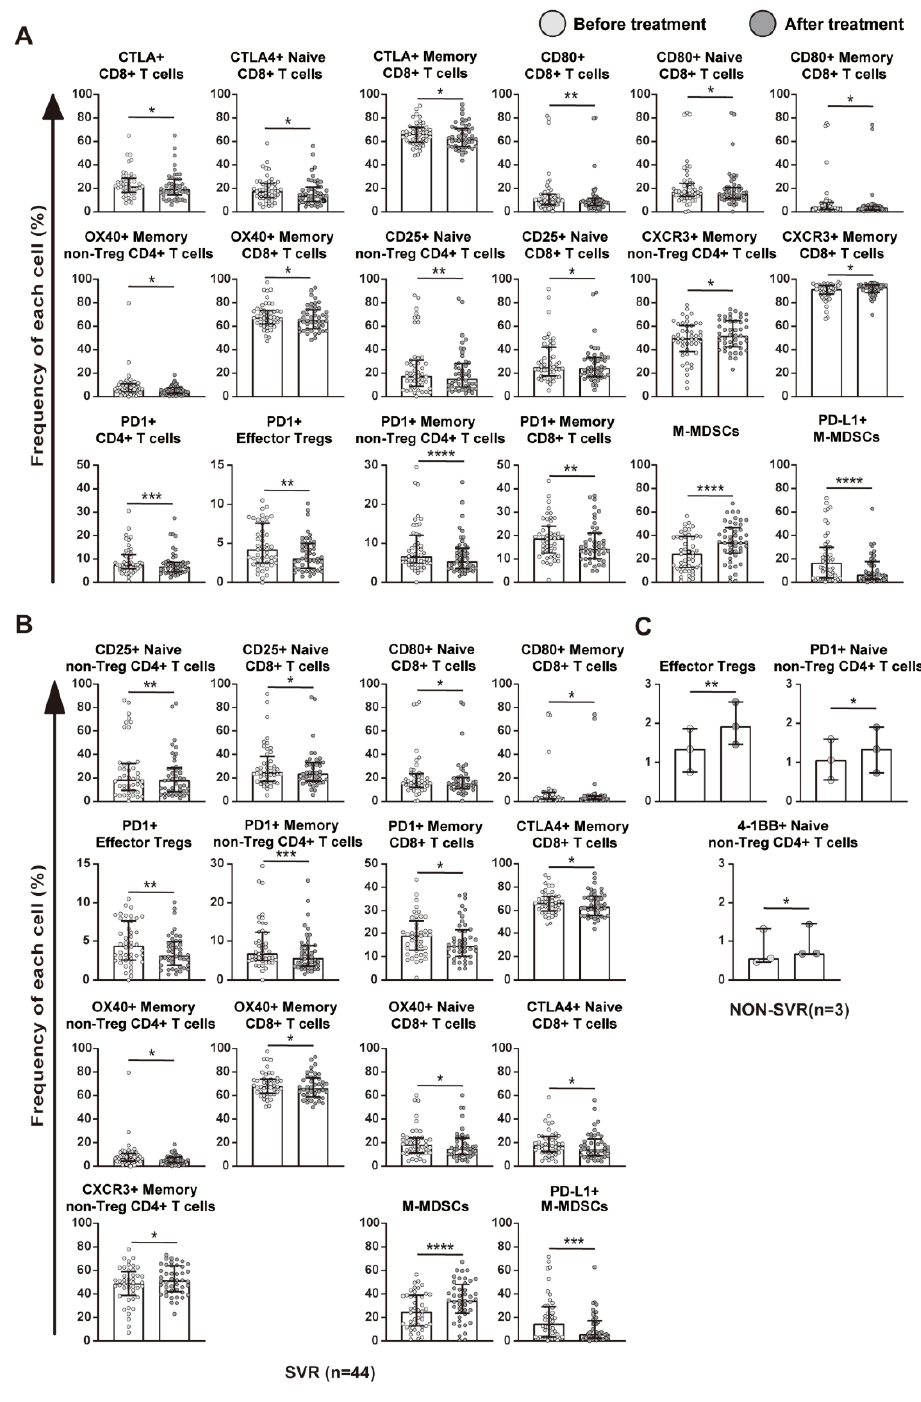
Figure 3. Changes in T cell and MDSC profiles before and after the treatment with DAAs. ( A ) Comparative analysis of the frequencies of each T cell and MDSC subpopulation before and after the treatment with DAAs by flow cytometry in all patients (n = 47). ( B ) Comparison of the frequencies of each T cell and MDSC subpopulation before and after the treatment with DAAs in the SVR group (n = 44). ( C ) Comparison of the frequencies of each T cell and MDSC subpopulation before and after the treatment with DAAs in the non-SVR group (n = 3). The figure only shows results with a significant difference. Box plots depict the median value with IQR. The paired t -test was used to calculate p values. * p < 0.05, ** p < 0.01, *** p < 0.001, **** p < 0.0001.